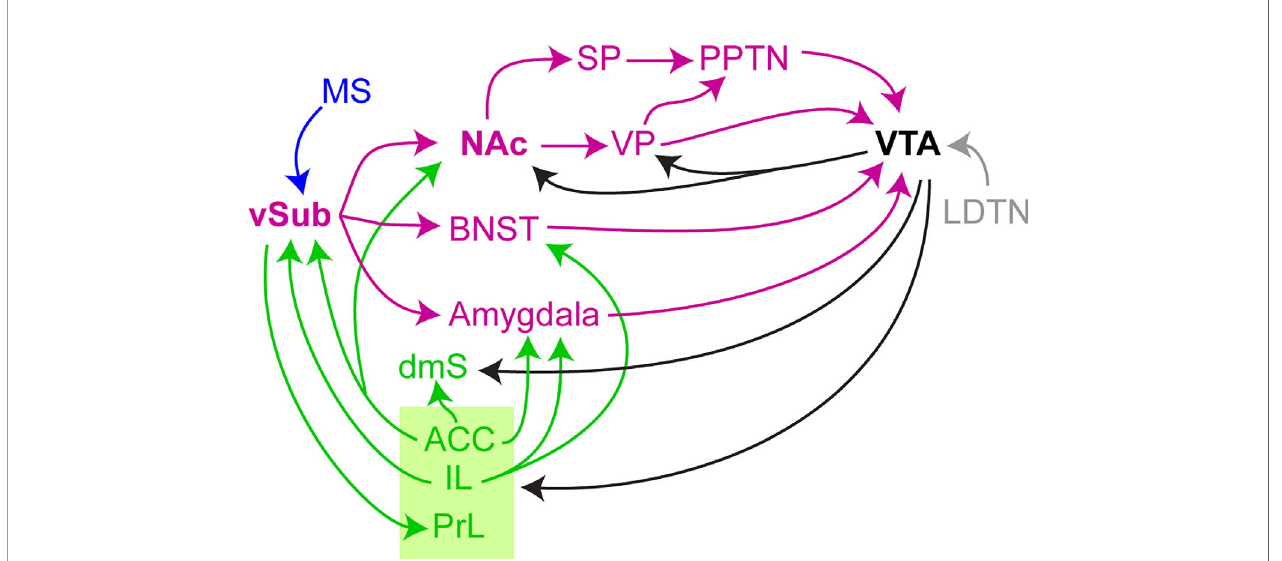
FIGURE 2 | Ventral hippocampal projections that regulate dopamine neuron activity and release. Different, but interacting circuits have been found to regulate dopaminergic signaling by the ventral tegmental area ( VTA ) (see main text and Tables 1 - 3 for description and references): projections from the ventral subiculum ( vSub , the output region of the vHC) target the VTA through the bed nucleus of the stria terminalis ( BNST ), the amygdala or through the ventral basal ganglia comprising the nucleus accumbens ( NAc ) and the ventral pallidum ( VP ) thereby determining the number of active dopamine neurons. Additional input from the pedunculo-pontine tegmental nucleus ( PPTN ) and the latero-dorsal tegmental nucleus ( LDTN ) determine if these active neurons enter into burst- fi ring mode with ensuing phasic dopamine release in the NAc. The PPTN is modulated indirectly by the vSub → NAc pathway via neurons in the subpallidal region ( SP ), comprising part of the VP, the lateral hypothalamus, and the substantia innominata. Medial septal ( MS , blue) and prefrontal in fl uences (green) from the infralimbic ( IL ) and anterior cingulate ( ACC ) cortex onto dopaminergic neurons act centrally through the vSub as well, but also through the NAc, BNST, and amygdala; the ACC also innervates the dorsomedial (associative) striatum ( dmS ) which has gained increasing attention as a key target of dopaminergic midbrain projections aside from the ventral striatum